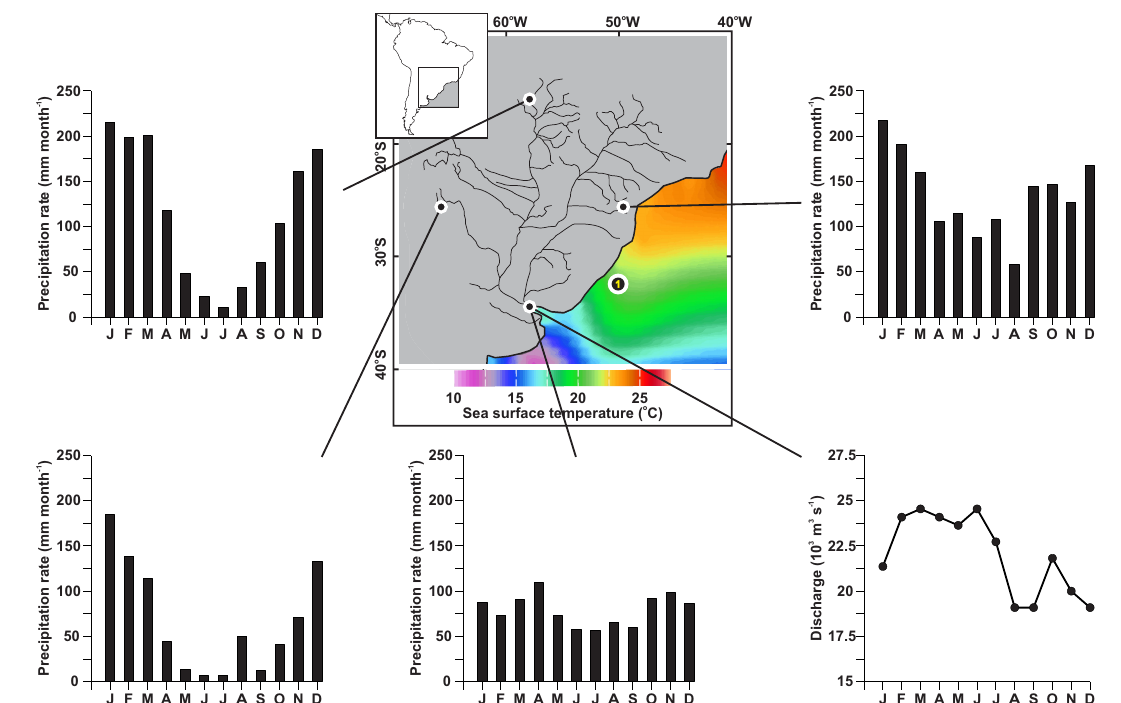
Figure 2. Histograms of the mean annual cycle of precipitation at selected stations in the La Plata River drainage basin (Xie and Arkin, 1997), and mean annual cycle of the La Plata River discharge on the lower right panel (Berbery and Barros, 2002). The color shading in the central panel depicts annual mean sea surface temperatures ( ◦ C) (Locarnini et al., 2010). The number “1” in the central panel indicates the location of marine sediment core GeoB6211-2 (this study). This figure was partly produced with Ocean Data View (Schlitzer,